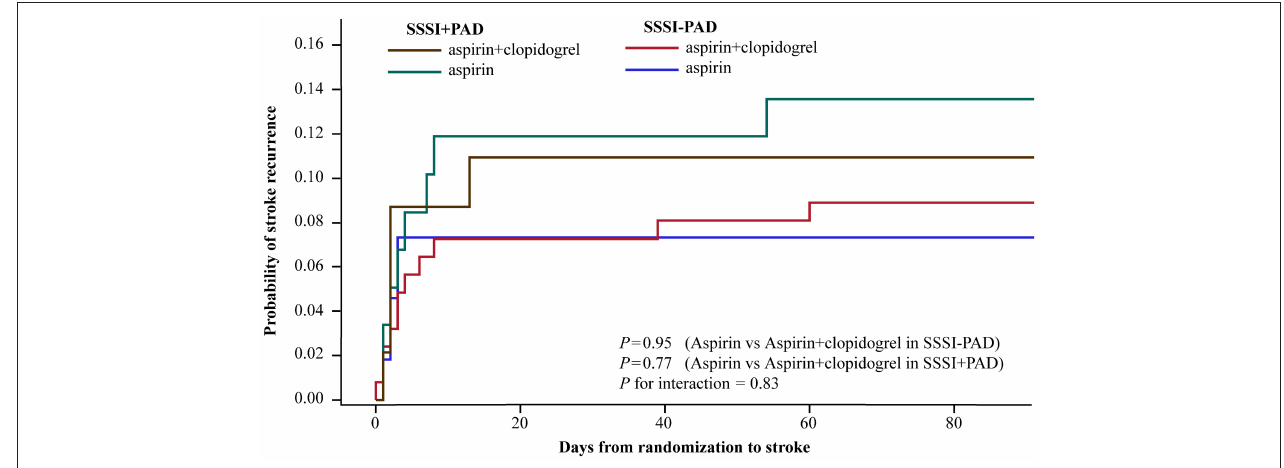
FIGURE 2 | Kaplan-Meier curves for the primary efficacy outcome of any stroke. Kaplan-Meier curves showing the time to the primary efficacy outcome event (any stroke) in patients with SSSI + PAD and SSSI – PAD, treated with clopidogrel plus aspirin, or placebo plus aspirin. SSSI, single small subcortical infarction; PAD, parental arterial